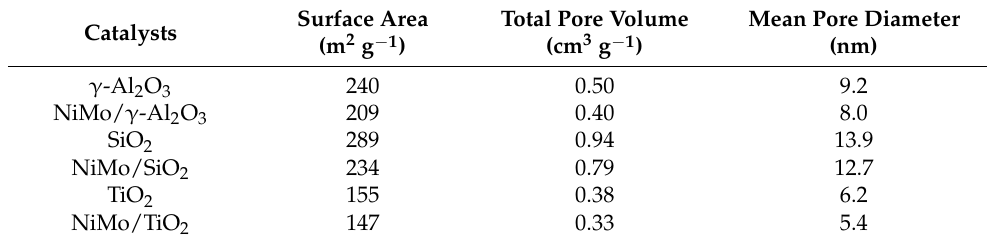
Table 3. Physicochemical properties of the calcined